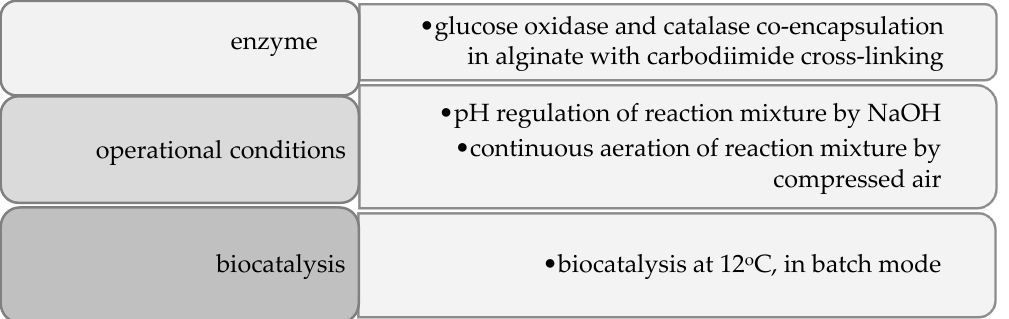
Figure 8. The road map of low-temperature biocatalysis to the reduction of calorific value and sweetness of lactose-free milk.